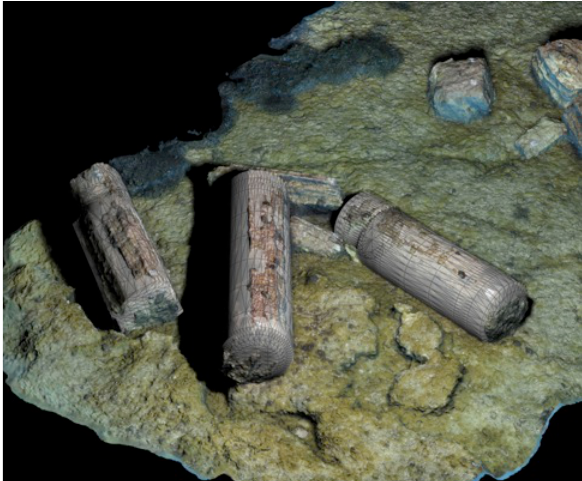
Figure 13. Marzamemi shipwreck. Model of the columns: ghosted view of polygonal reconstruction on the original mesh.